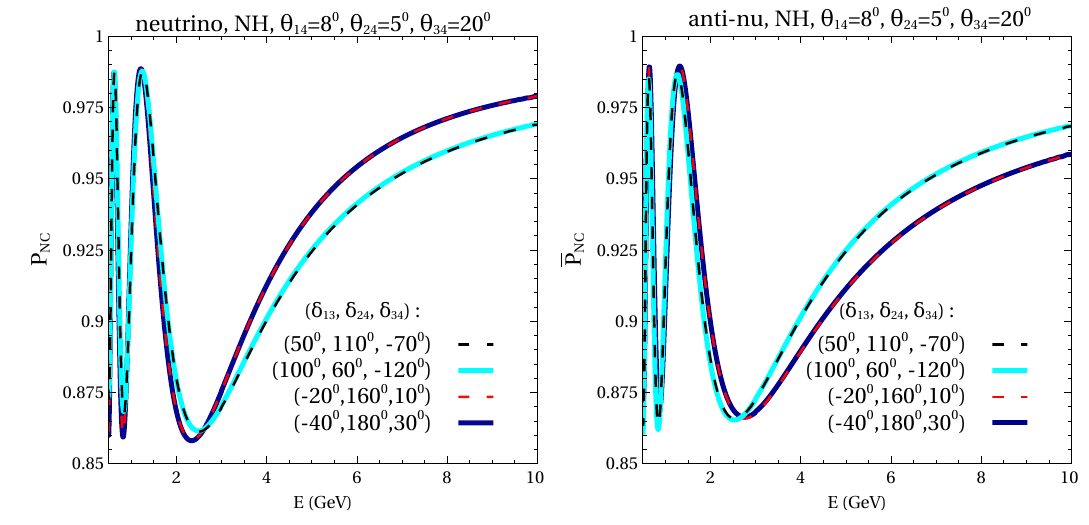
Figure 5 . P NC vs Energy (in GeV) assuming normal hierarchy for L = 1300 km in the presence of matter. (cid:18) 14 = 8 (cid:14) ; (cid:18) 24 = 5 (cid:14) ; (cid:18) 34 = 20 (cid:14) ((cid:12)xed). The left (right) panel corresponds to neutrino (anti-neutrino) probabilities. Di(cid:11)erent values of (cid:14) 13 ; (cid:14) 24 ; (cid:14) 34 are chosen as shown in the